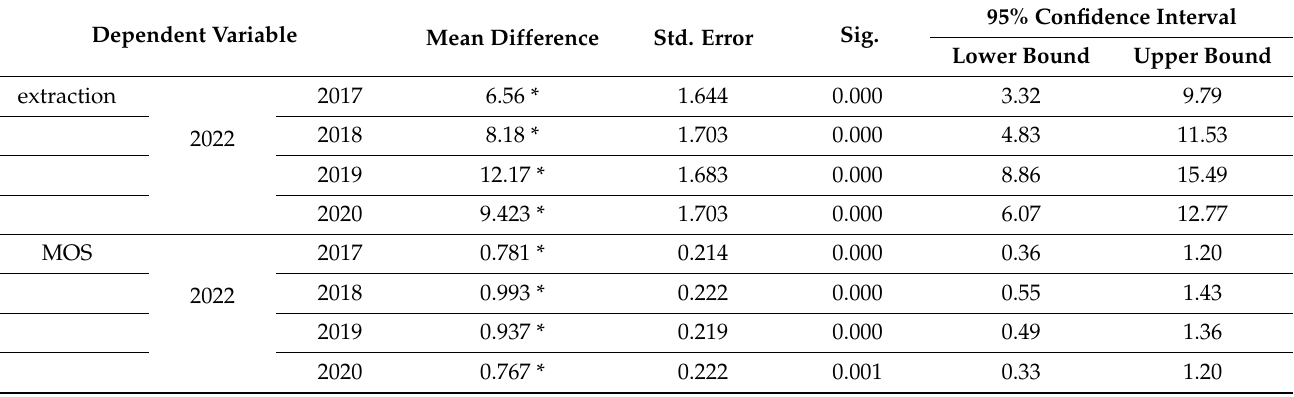
Table 4. Comparison between extraction and MOS between the extended year of 2022 and the previous years of 2017–2020 using a post hoc Least Significant Difference